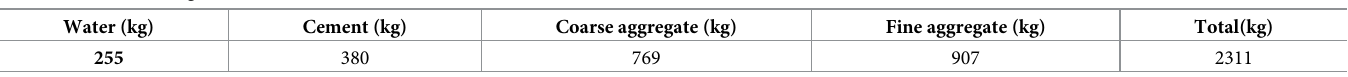
Table 4. Mass of the ingredients of the concrete.